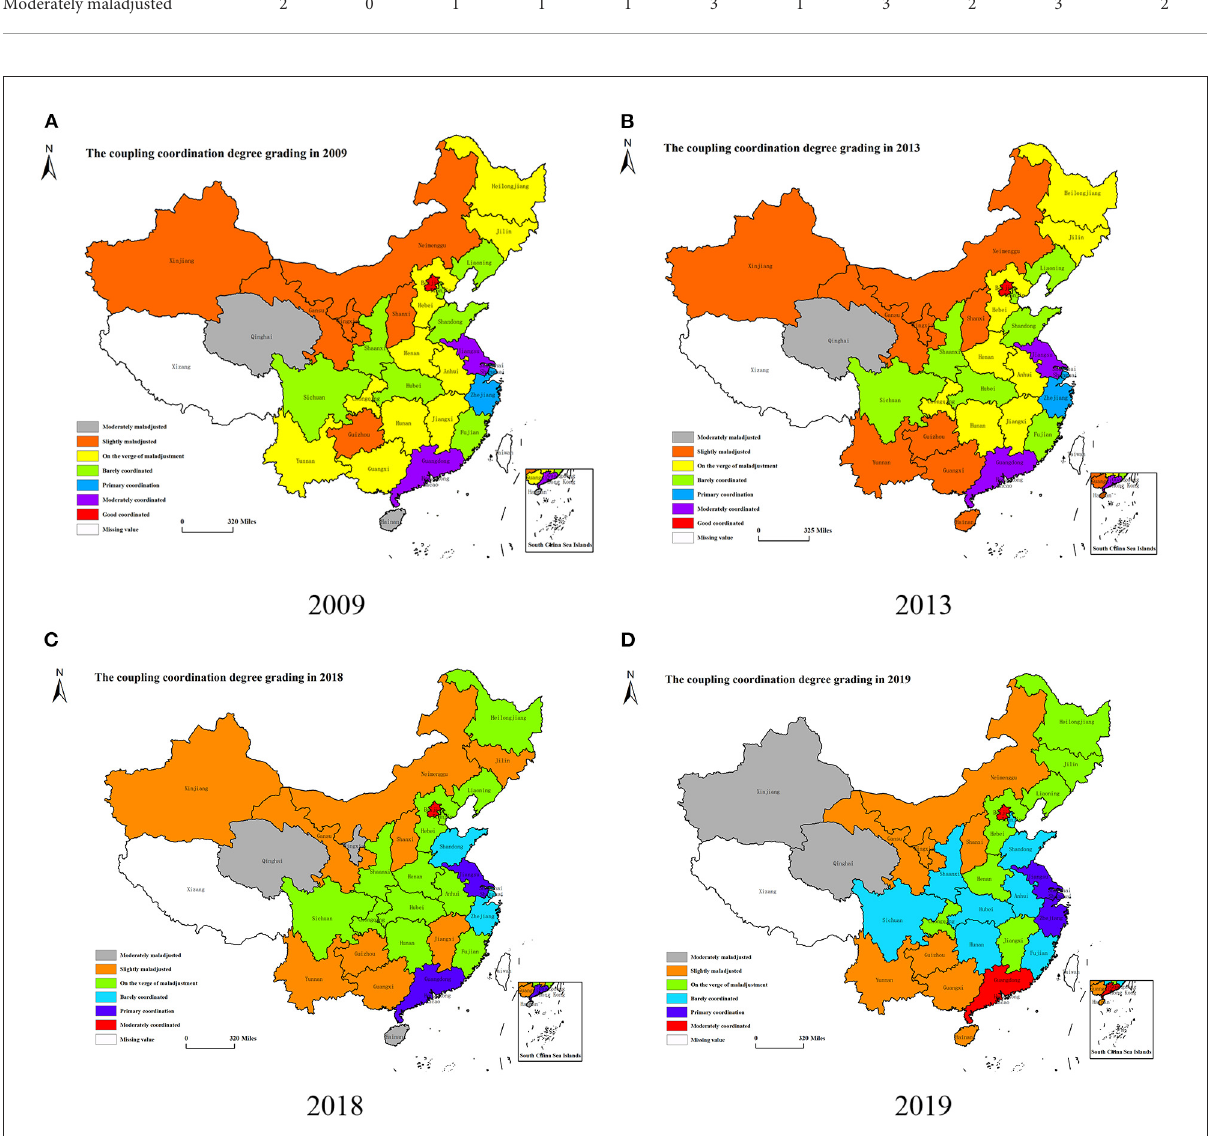
FIGURE7 (A–D) Spatial distribution of coupling coordination degree of “LCD-TI-NU” system in some